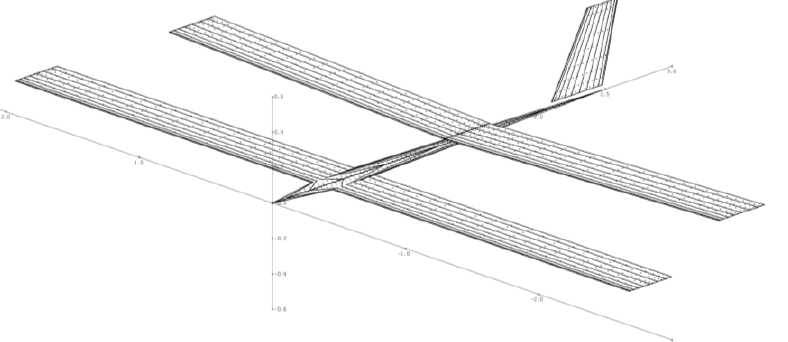
Figure 9. VLM model of the test aircraft created with AVL.